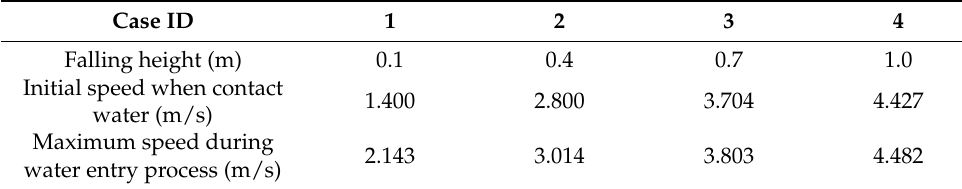
Table 3. Investigation conditions involved in this